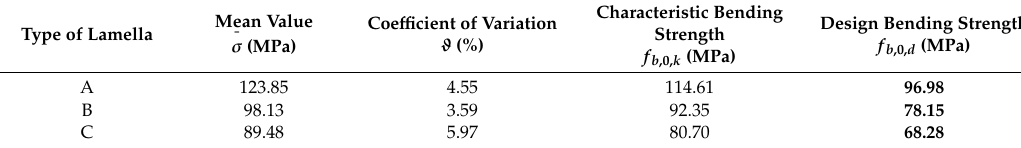
Table 3. Calculated values of mold